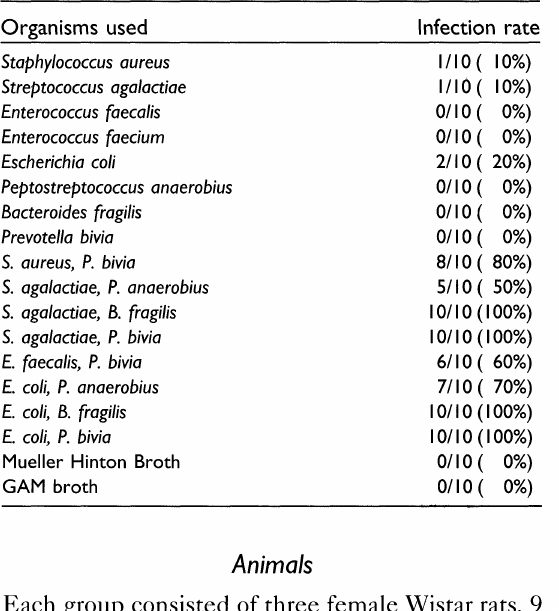
TABLE I. The incidence of pyometra by various bacteria in the experimental model Organisms used Infection rate